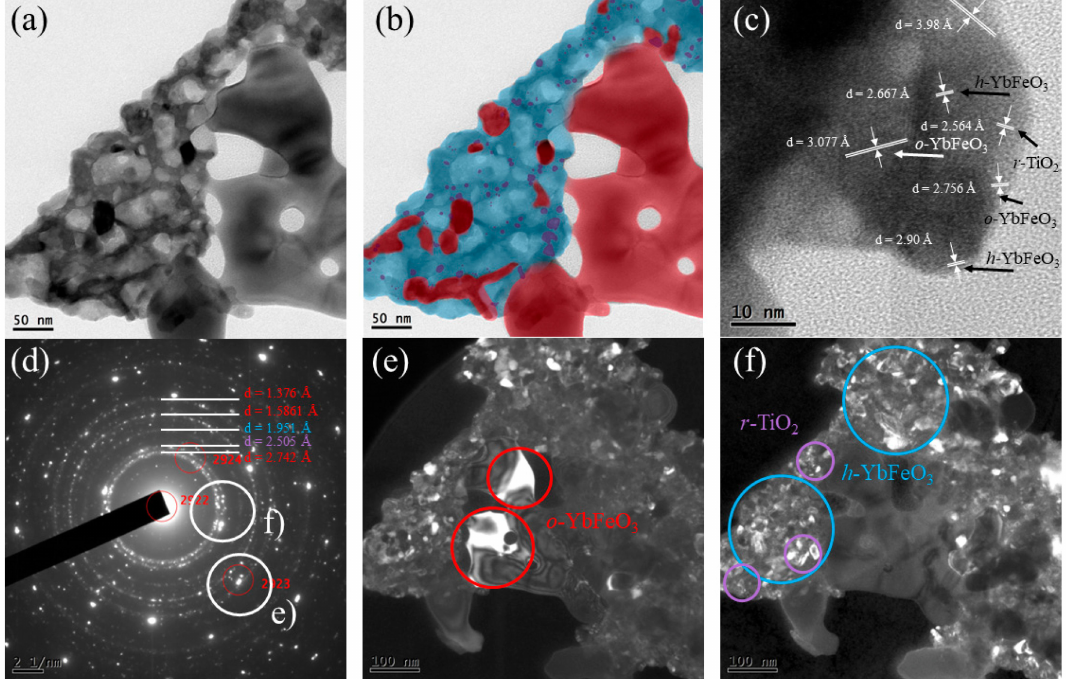
Figure 5. TEM images of the h -YbFeO 3 / o -YbFeO 3 /TiO 2 –5% sample: ( a ) an overview of the o - YbFeO 3 / h -YbFeO 3 /TiO 2 nanocomposite, ( b ) color designation of phases: red— o -YbFeO 3 , blue— h - YbFeO 3 , purple— r -TiO 2 , ( c ) the h -YbFeO 3 to o -YbFeO 3 and to r -TiO 2 heterojunction, ( d ) selected area transmission electron diffraction (SAED) pattern and dark-field TEM of o -YbFeO 3 ( e ) and h -YbFeO 3 , r -TiO 2 ( f )